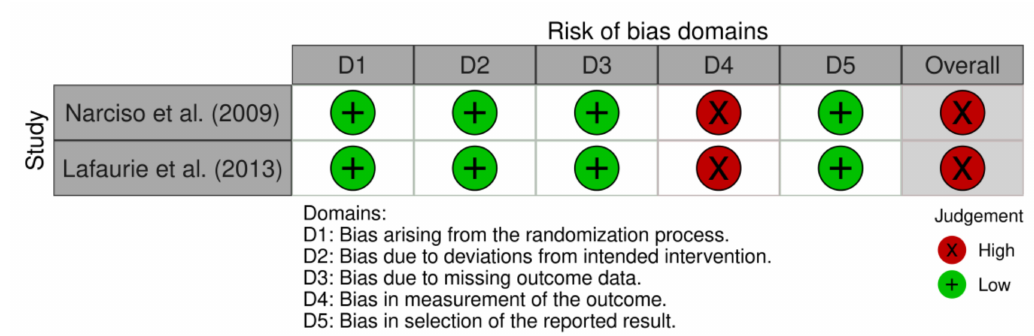
Figure 1. Flow diagram of literature search and study selection.